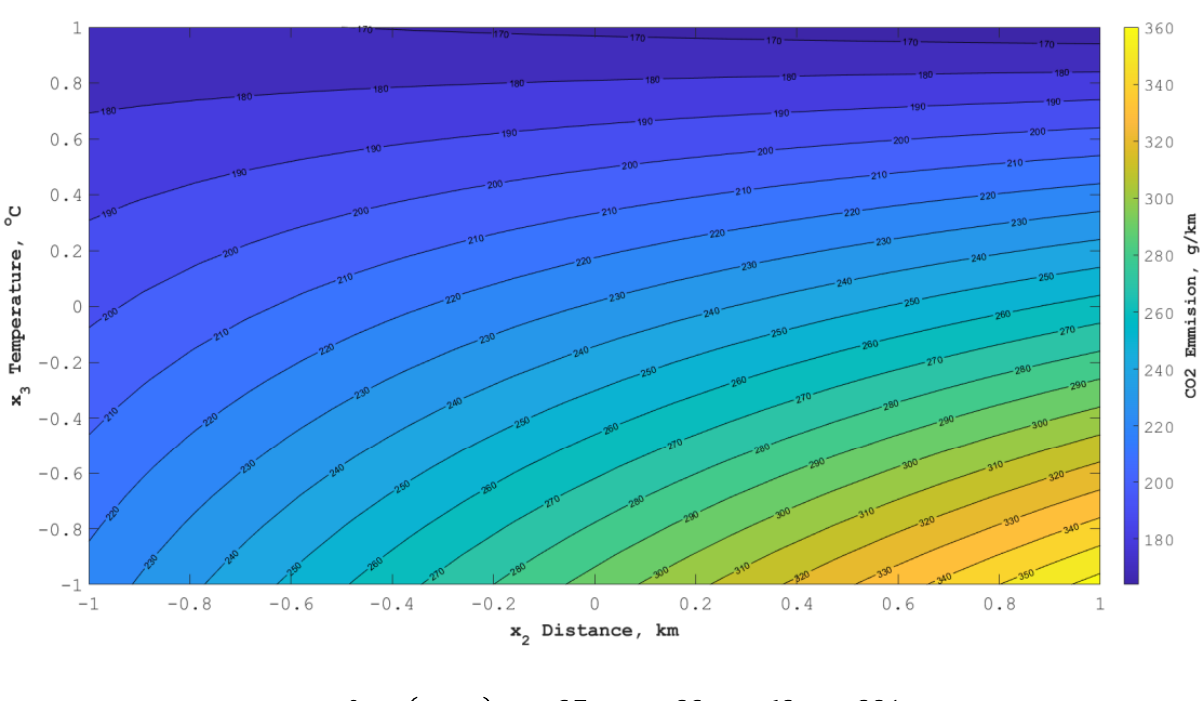
Figure 2. Change in CO 2 emissions depending on the variability of factors x 2 and x 3 for a vehicle (ICE) moving for 30 min (x 1 = −1 ).